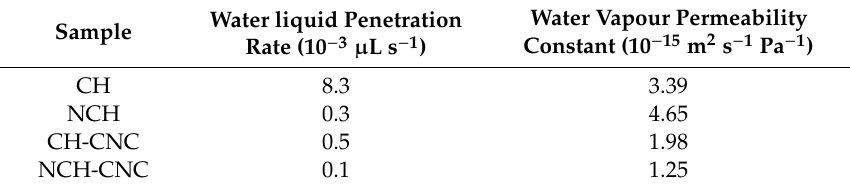
Table 2. Water-resistance properties of film composites.